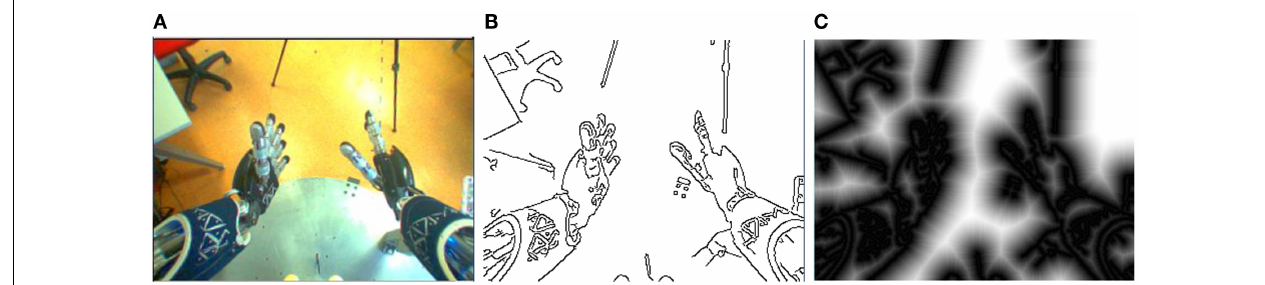
FIGURE 5 | Example of the computation of the edges and distance transform of the iCub hand in a real environment on the right camera . (A similar example can be shown for the left camera.) (A) is the input image, (B) shows the edges extraction using Canny, 1986, and (C) the distance transform using Borgefors,